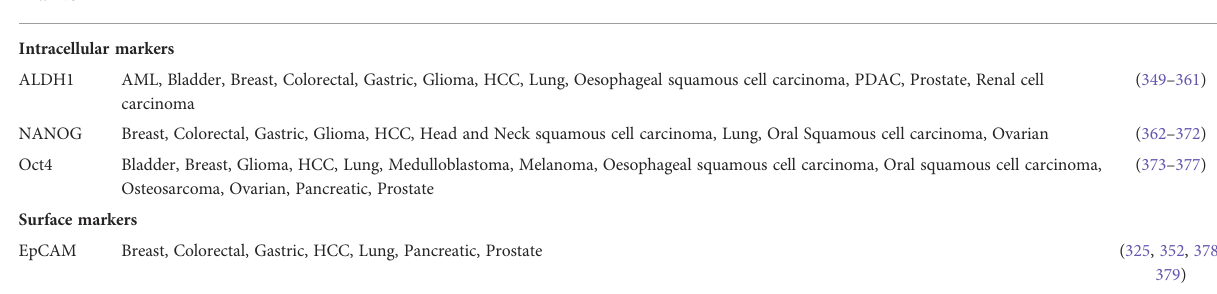
TABLE 3 A summarized form of certain CSC markers expressed on their target CSCs. CSC marker